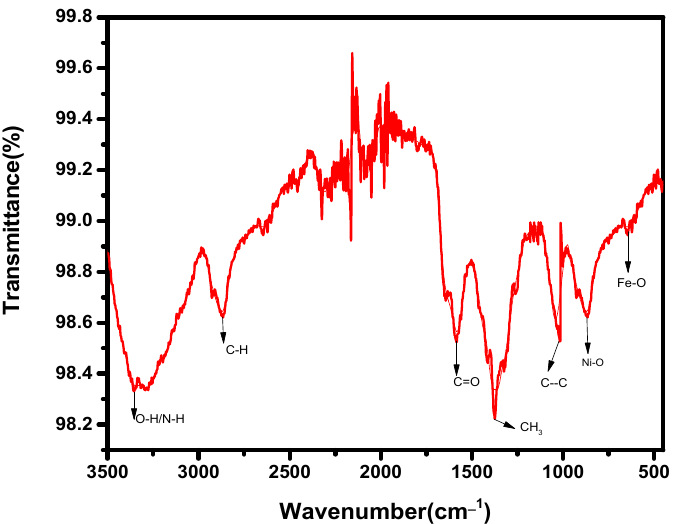
Figure 2. FTIR spectrum of CS-NM bio-composite.